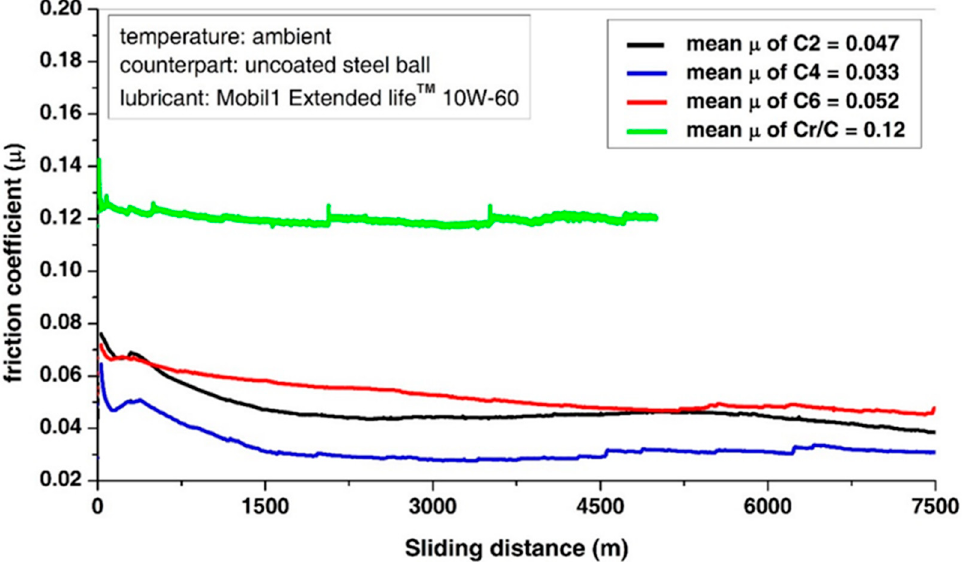
Figure 6. Friction behavior of C2, C4 and C6 in lubricated condition at ambient temperature (Cr/C coating is used as a reference).